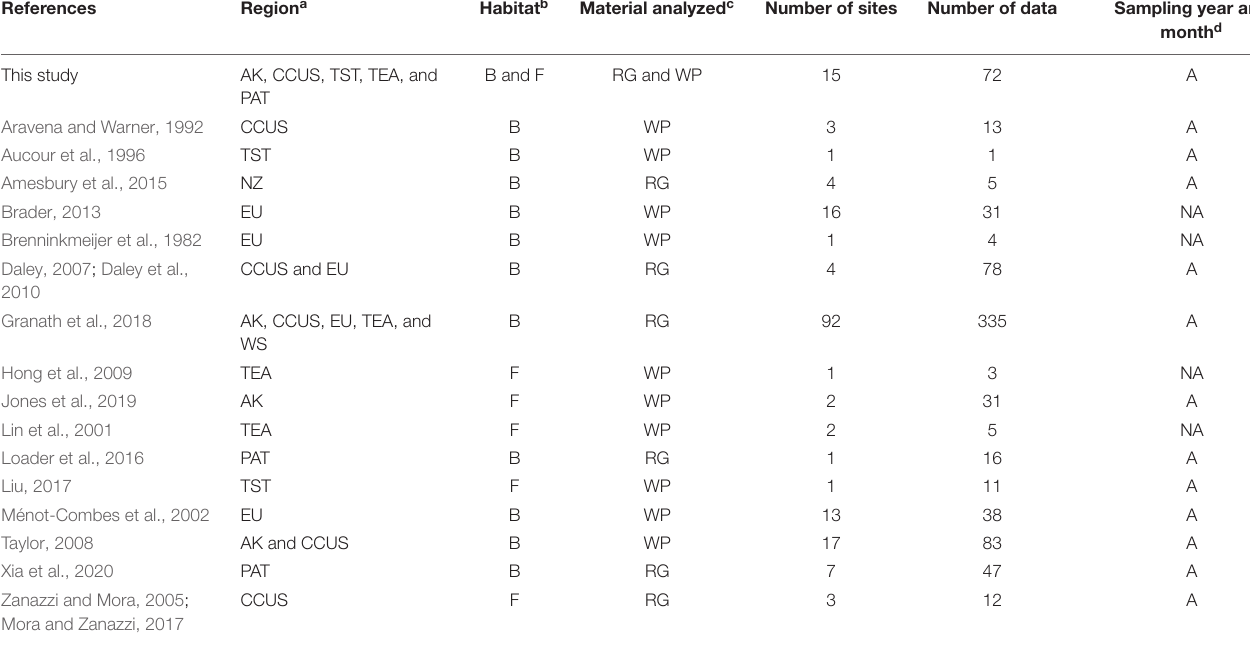
TABLE 1 | Summary information about the compiled Sphagnum δ 18 O